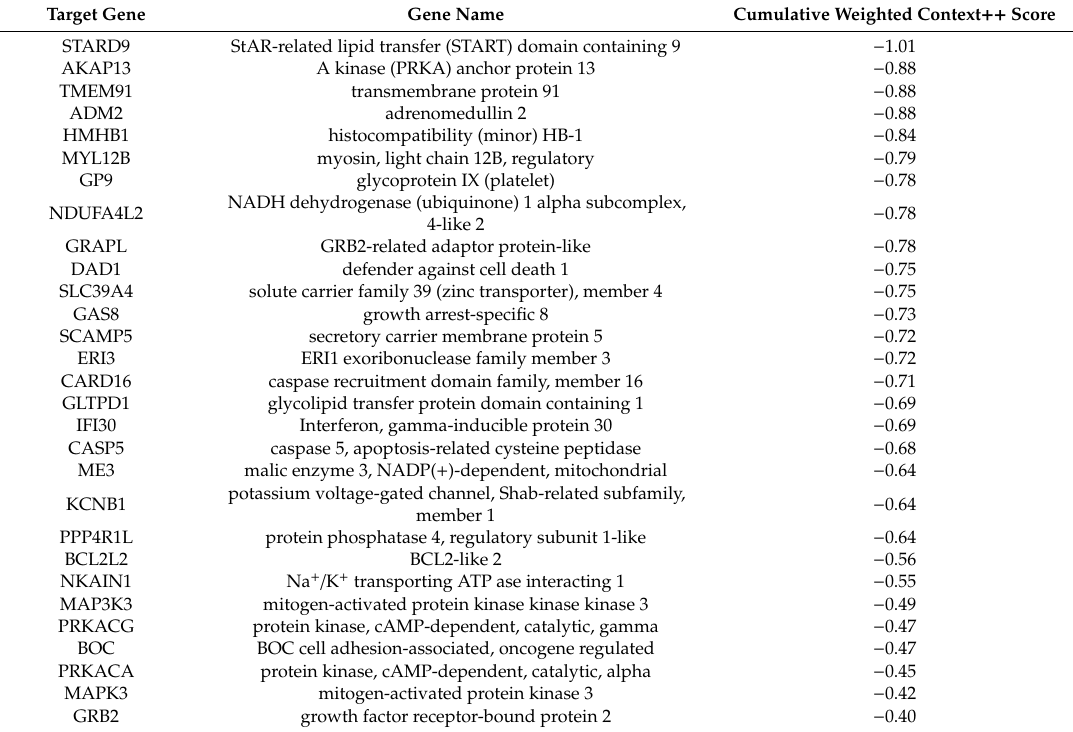
Table 7. List of predicted microRNA 378g target